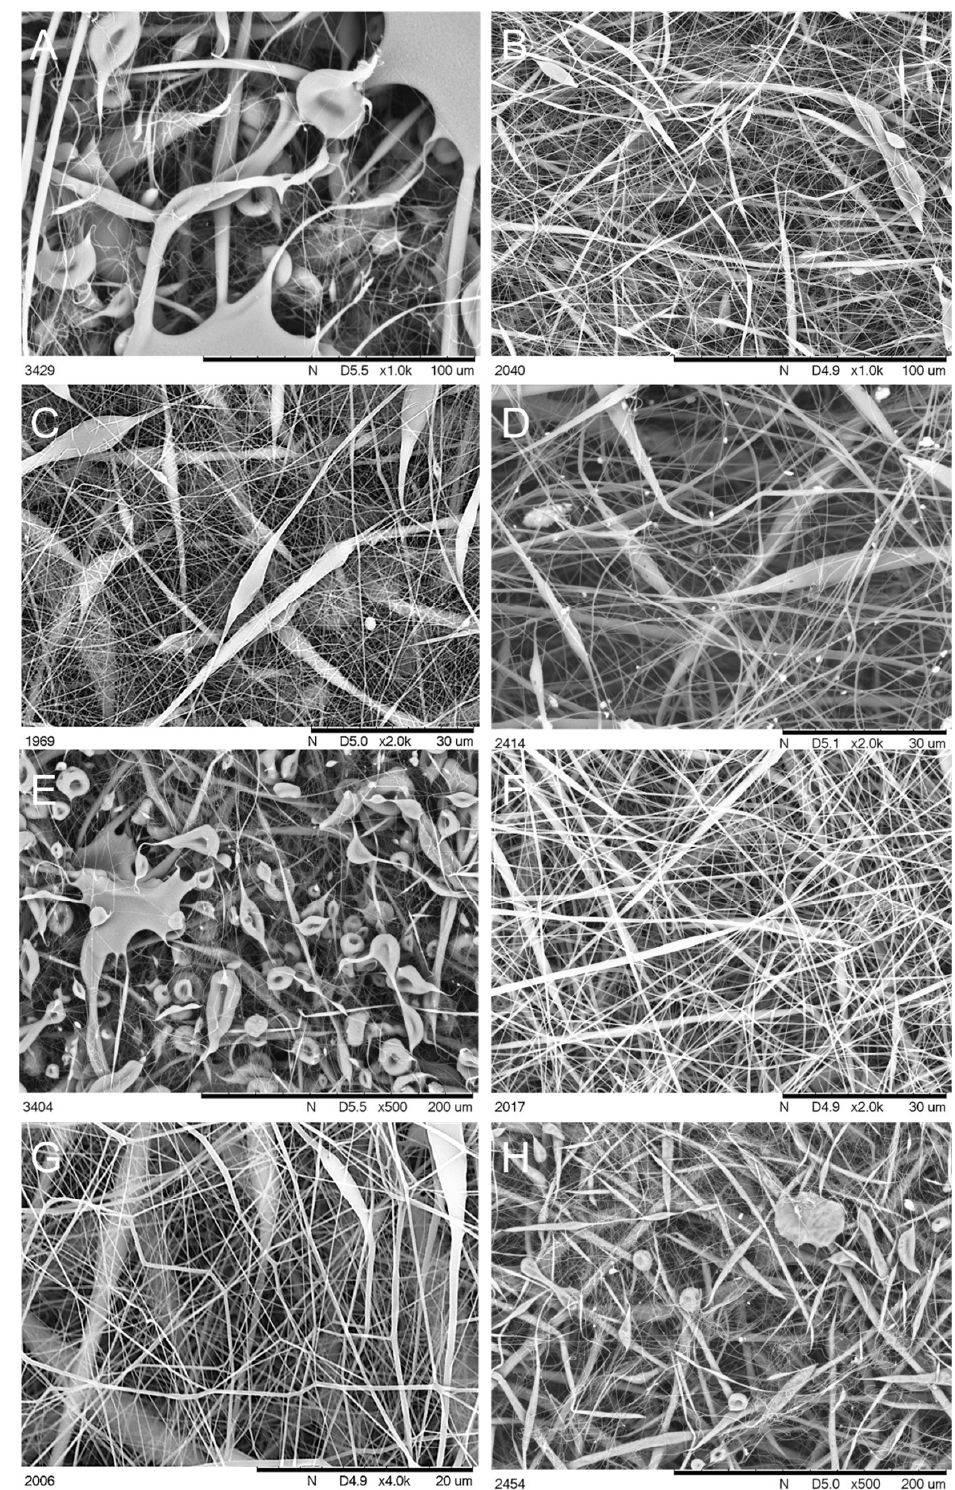
Figure 2. SEM images of membranes electrospun from PLA doped with cage siloxane compounds used in this study; ( A ) S-Limonene under condition (2); ( B ) SS-Limonene under condition (3); ( C ) iBu 7 SSQ-3OH under condition (2); ( D ) iBu 7 SSQ-3OH under condition (3); ( E ) iBu 7 SSQ-OEt under condition (1); ( F ) iBu 7 SSQ-OEt under condition (2); ( G ) SSQ-8Cl under condition (2); ( H ) SSQ-8Cl under condition (3).